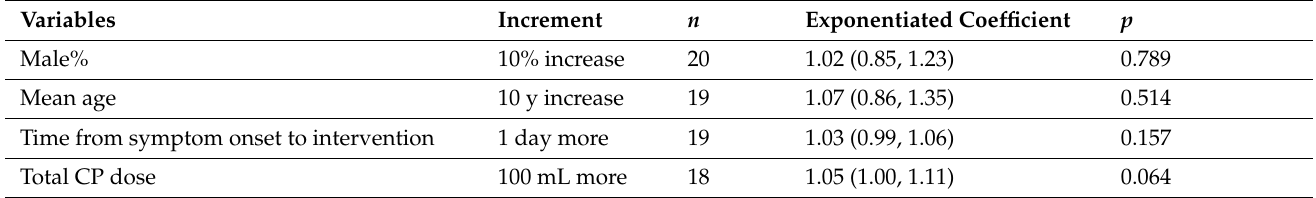
Table 11. Results of meta-regression analysis examining the role of potential modifiers in the associa- tion between convalescent plasma treatment and 28-day ICU-related